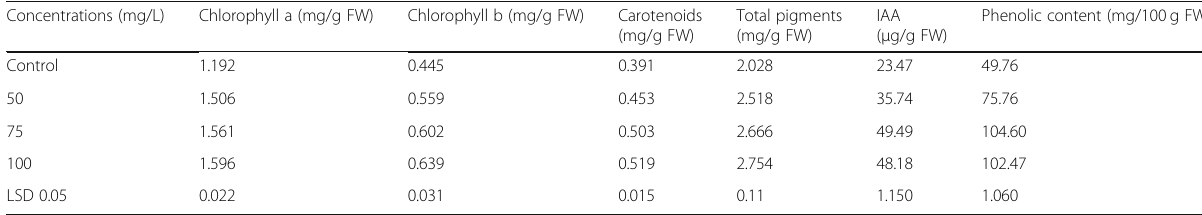
Table 9 Effect of phenolic acid concentrations on photosynthetic pigments, IAA, and phenolic contents of flax plants grown under sandy soil conditions (data are means of two successive seasons) Concentrations (mg/L)